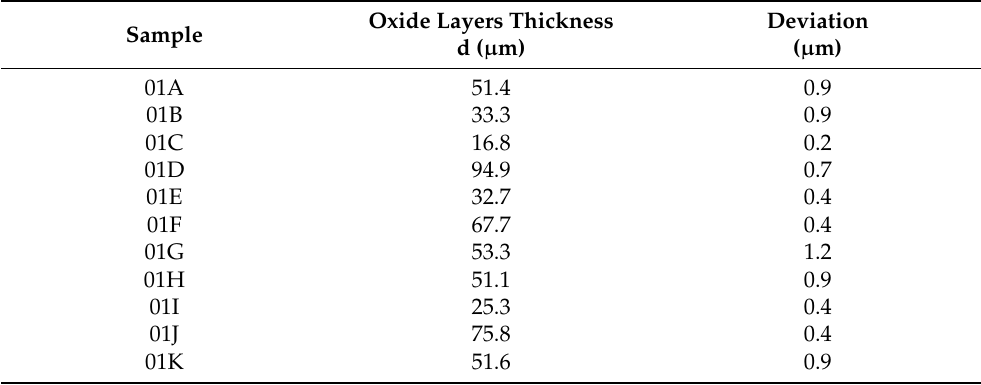
Table 3. List of thicknesses of Al 2 O 3 layers produced in anodizing process according to Hartley’s plan (without thermo-chemical treatment). Oxide Layers Sample